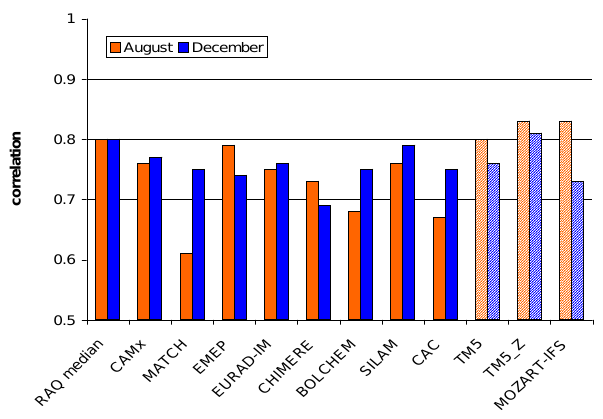
Fig. 7. Spatial correlation in August and December for the ensemble median and all individual models versus OMI over the mid/south RAQ